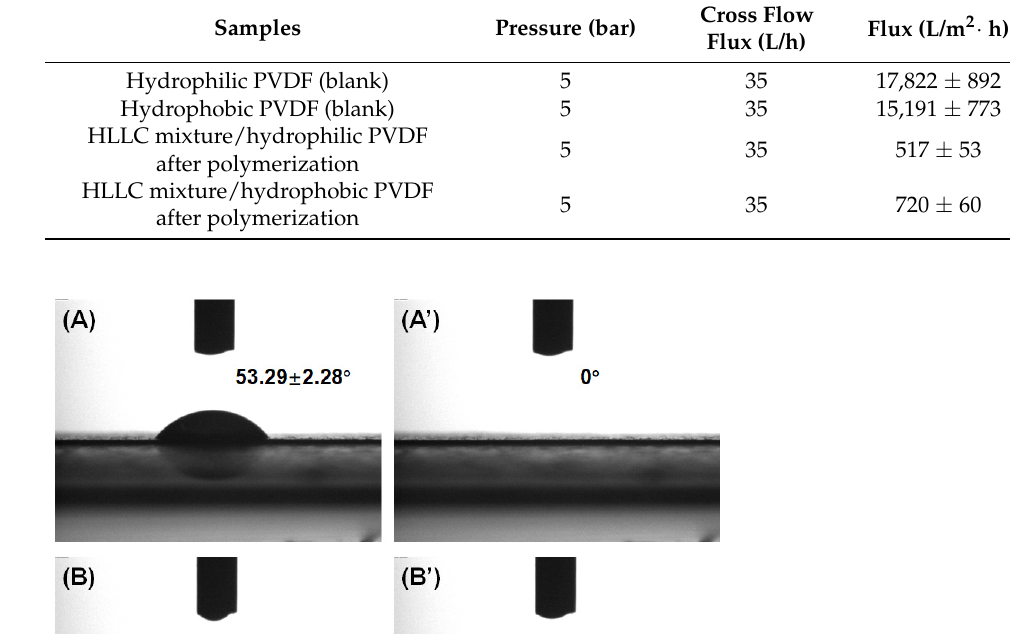
Table 2. Water flux for microporous substrates and TFC membranes.